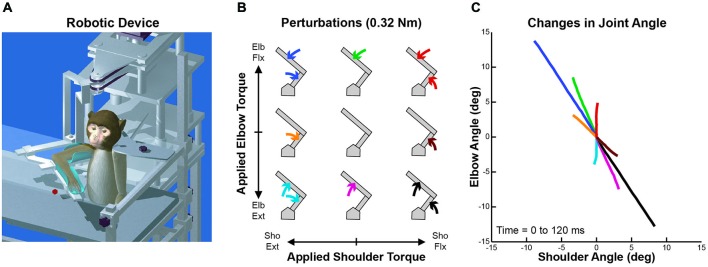
Robotic device, perturbation conditions and perturbation-evoked kinematics. (A) Schematic representation of the KINARM exoskeleton robot used in the study. (B) Arrangement of the nine perturbation conditions applied to the monkey’s upper-limb. Joint torques imposed at the shoulder and elbow joints are represented along the x and y axes, respectively (joint-torque space: flexor torque positive and extensor torque negative). Modified from Herter et al. (2009). (C) Joint motion evoked by each perturbation condition. Changes in shoulder and elbow angle in first 120 ms after perturbation onset are represented along the x and y axes, respectively (flexion positive and extension negative). Colors of each line are associated with the respective perturbation conditions in (B). Modified from Herter et al. (2009).